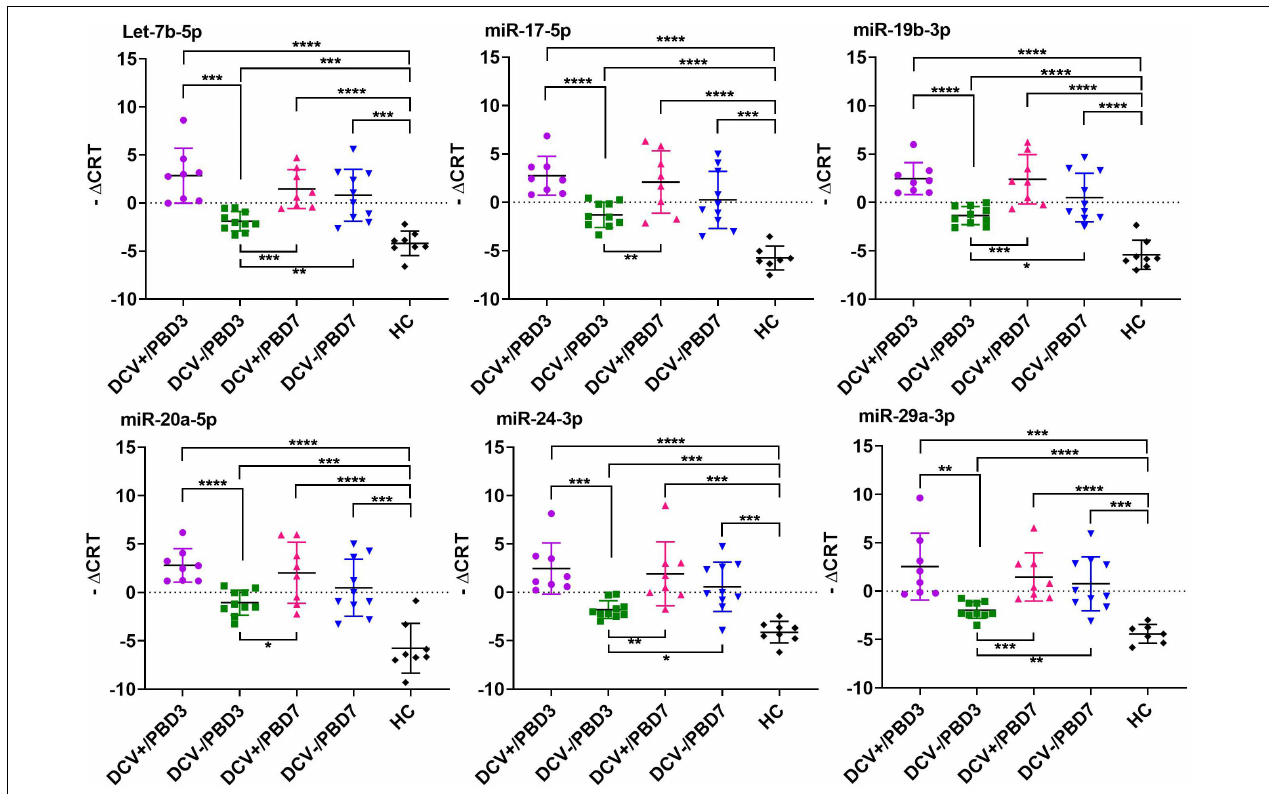
FIGURE 3 | Individual CSF miRNAs that showed highly differential expression in DCV+, DCV-, and HC groups. The differential miRNA expression levels are expressed as – (cid:49) C RT and a two tailed Student’s t -test was used to evaluate differences between groups. Significant levels expressed as: **** p < 0.0001; *** p = 0.0001–0.001; ** p = 0.001–0.01; * p =